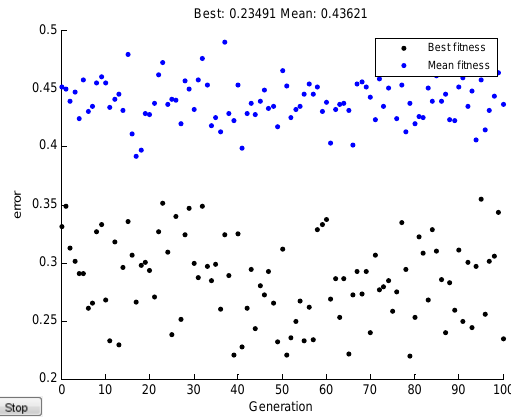
Fig 13 (a) Performance of GA for Lenses data set Fig 13 (b) Performance of Selectively Cloned GA for Lenses data set